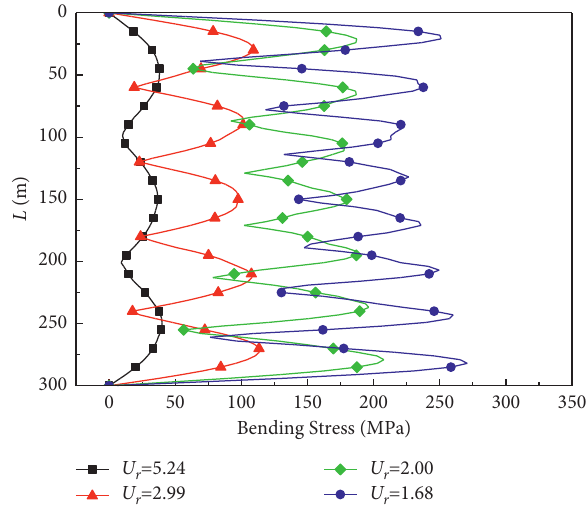
Figure 12: VIV bending stress distribution of riser under different reduced velocities.